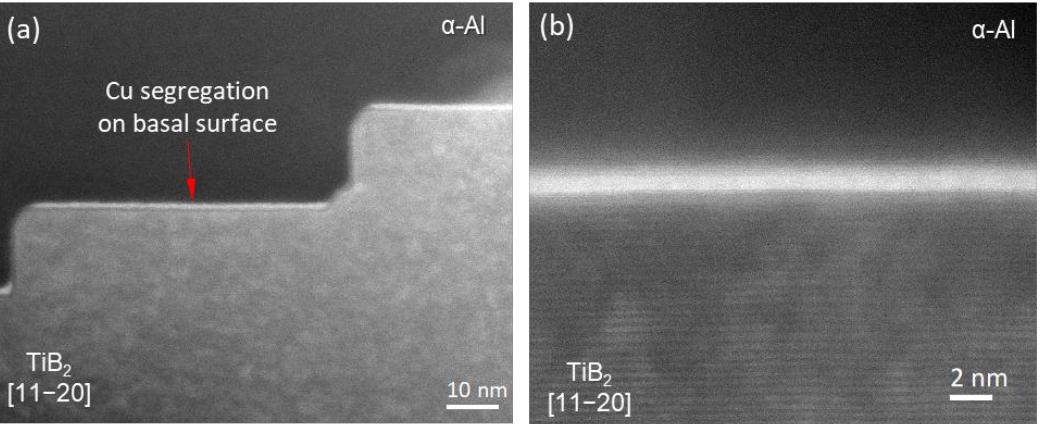
Figure 22. Cu segregation at Al/TiB 2 interface. STEM HADDF images show ( a ) general view and ( b ) local region across the Al/TiB 2 interface for a TiB 2 particle in Al-3Ti-1B-4.2Cu alloy, where a bright segregation layer is visible on the (0 0 0 1)TiB 2 basal surface but not on the (1 1 0 0) prismatic surface of the TiB 2 .